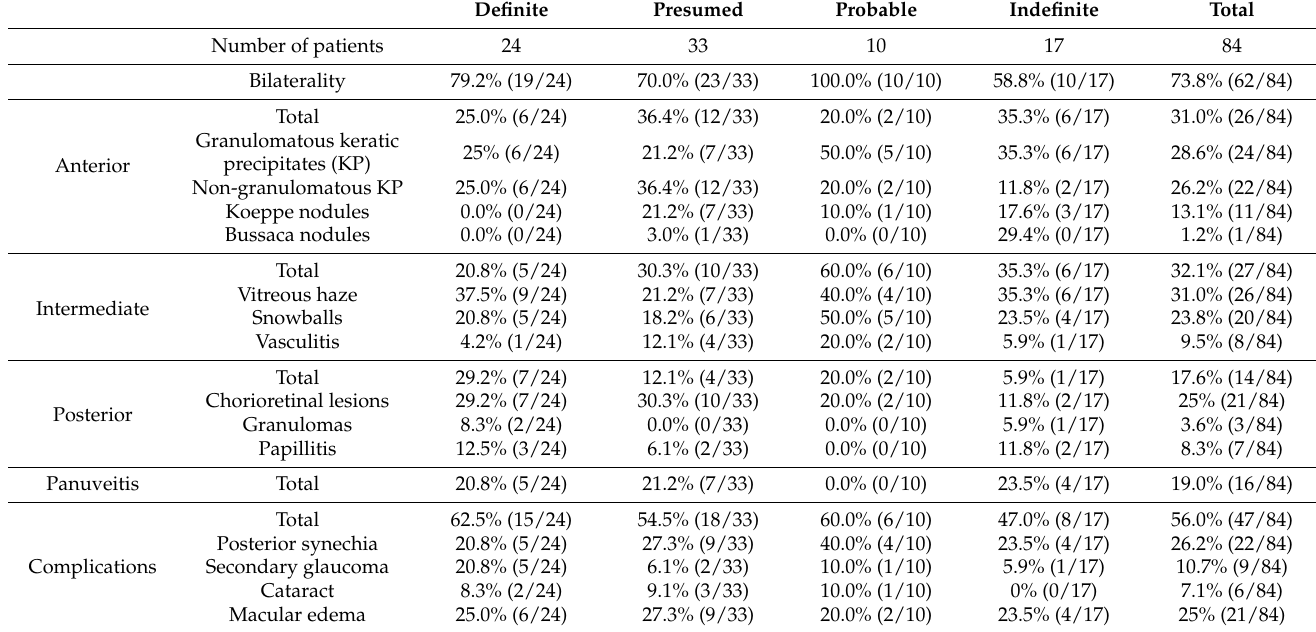
Table 4. Clinical manifestations and complications of ocular sarcoidosis patients.